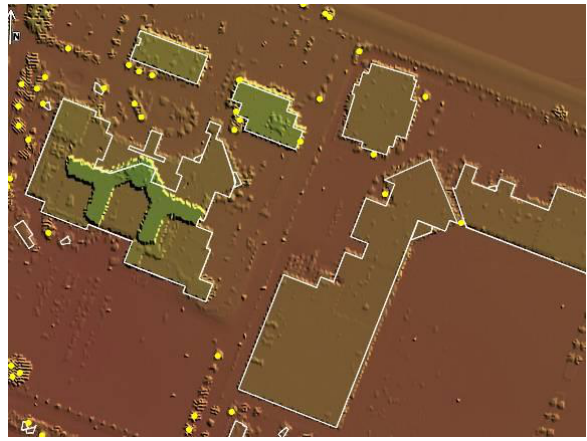
Figure 8. Complex buildings with irregular sides.